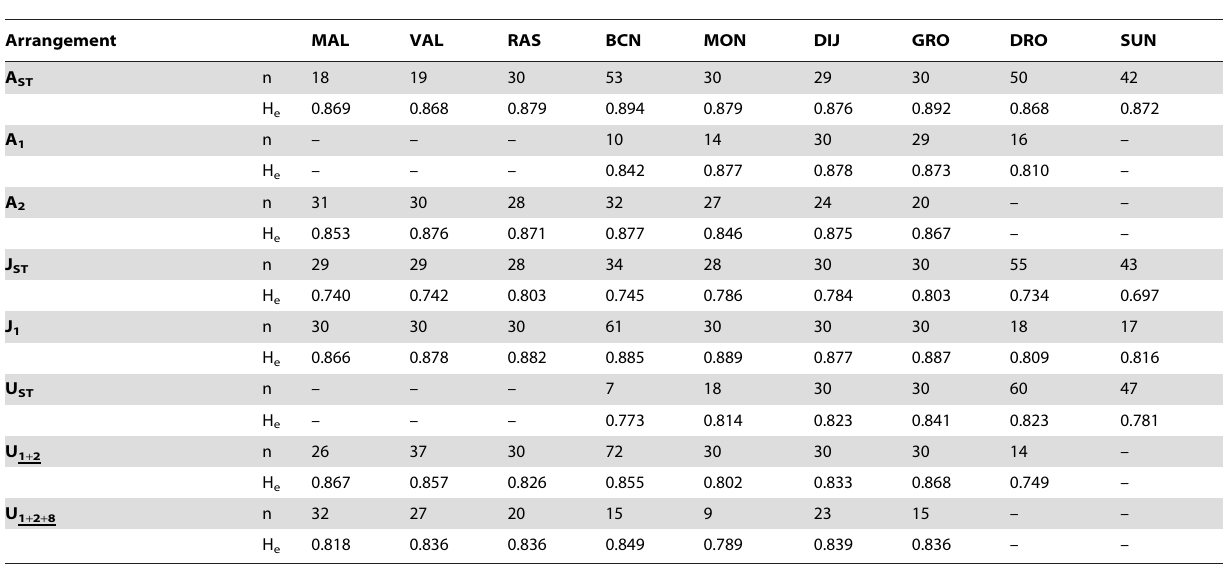
Table 1. Number of analyzed chromosomes (n) and molecular genetic variability (H e ) for each population and chromosomal